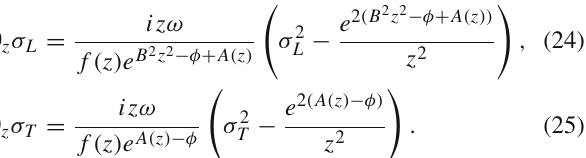
tion are calculated by using the membrane paradigm